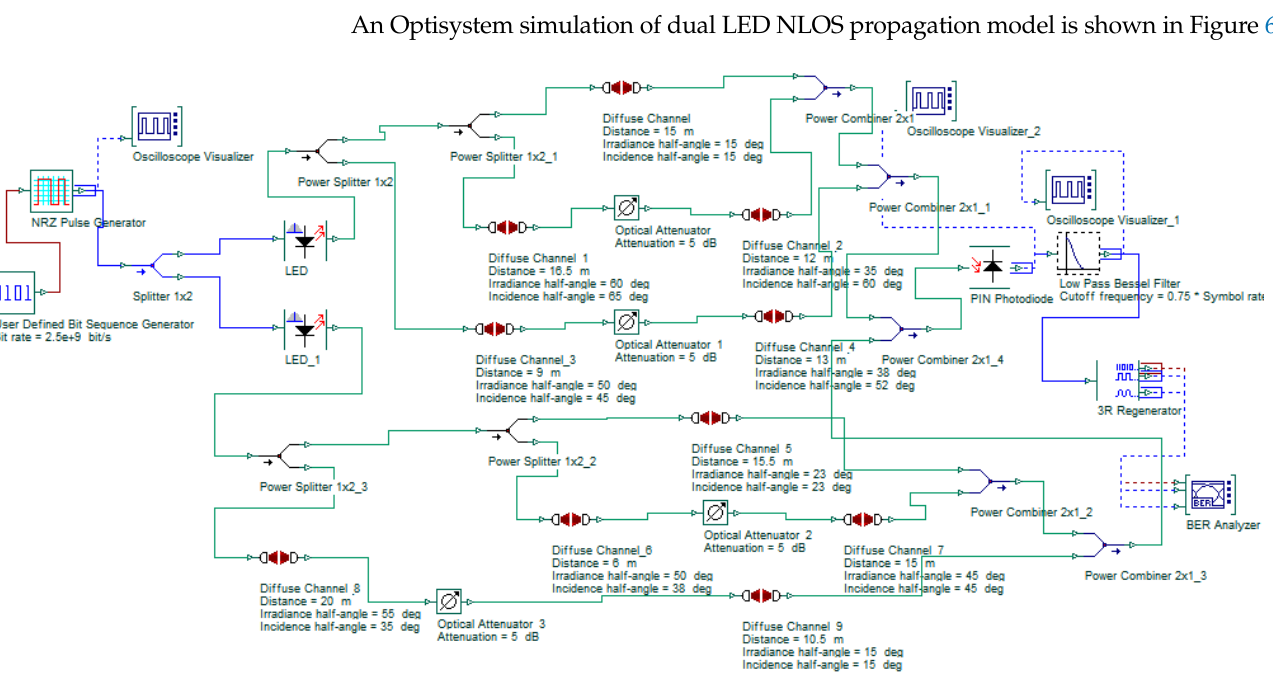
Figure 6. Dual LED NLOS propagation model simulation environment in